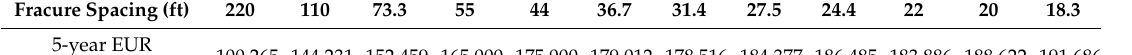
Figure 6. Forecasts for 5-year and 30-year estimated ultimate resource (EUR) (Mscf), due to ( a ) fracture spacing changes between 220 and 18.3 ft, and ( b ) well spacing changes between 200 and 1300 ft. ResFrac integrated simulator. Table 2. Variation of 5-year and 30-year EURs (Mscf) when producing with fracture spacing varying between 220 and 18.3 ft, as forecasted by the ResFrac integrated simulator.